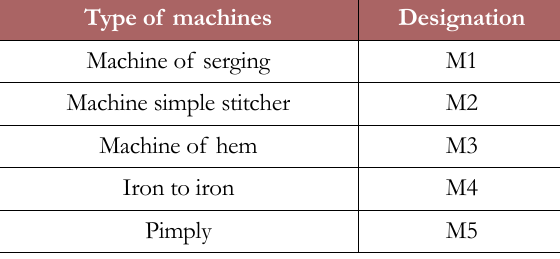
Table 1. Type of